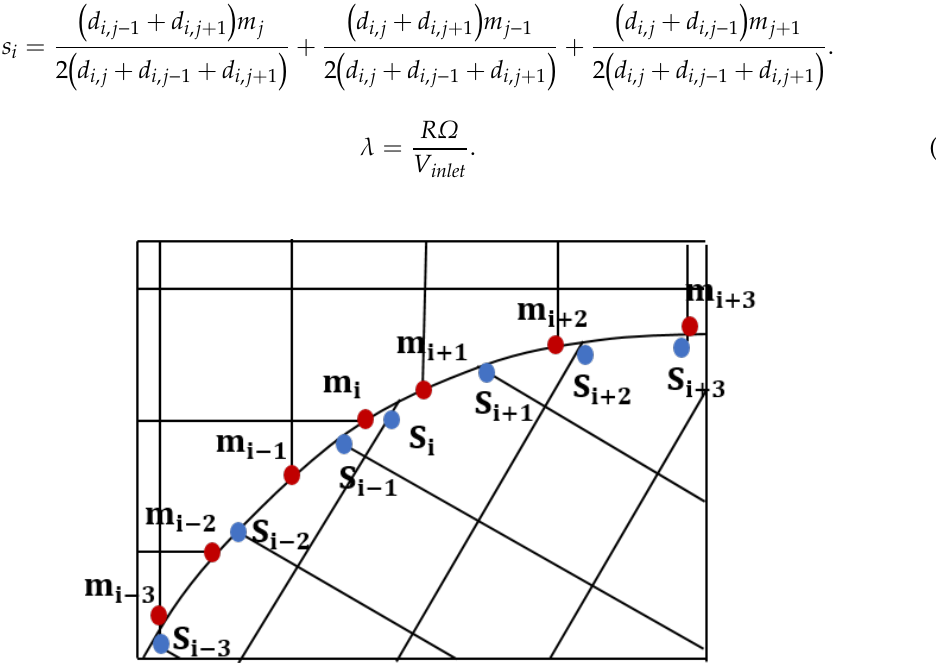
Figure 6. Physics quantity interpolation between the arbitrary mesh interface.